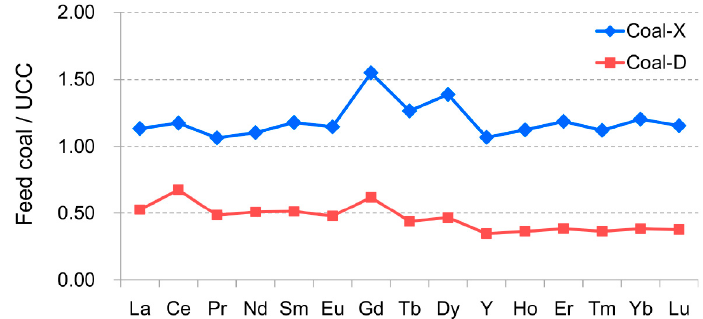
Figure 5. Distribution patterns of rare earth elements and yttrium (REY) in the feed coals (on average) from the Xilaifeng (X) and Damo (D) power plants. REY are normalized to upper continental crust (UCC) [55].